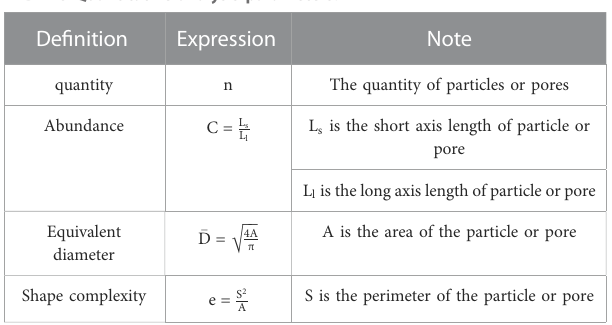
TABLE 3 Quantitative analysis